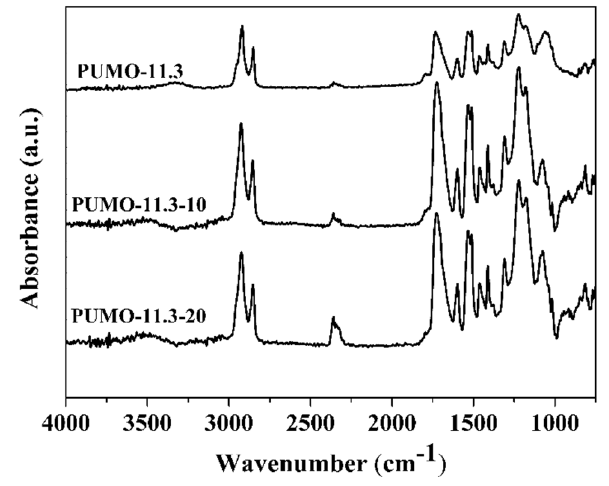
Figure 2. FTIR spectra of PUMO-11.3, PUMO-11.3-10, and PUMO-11.3-20.